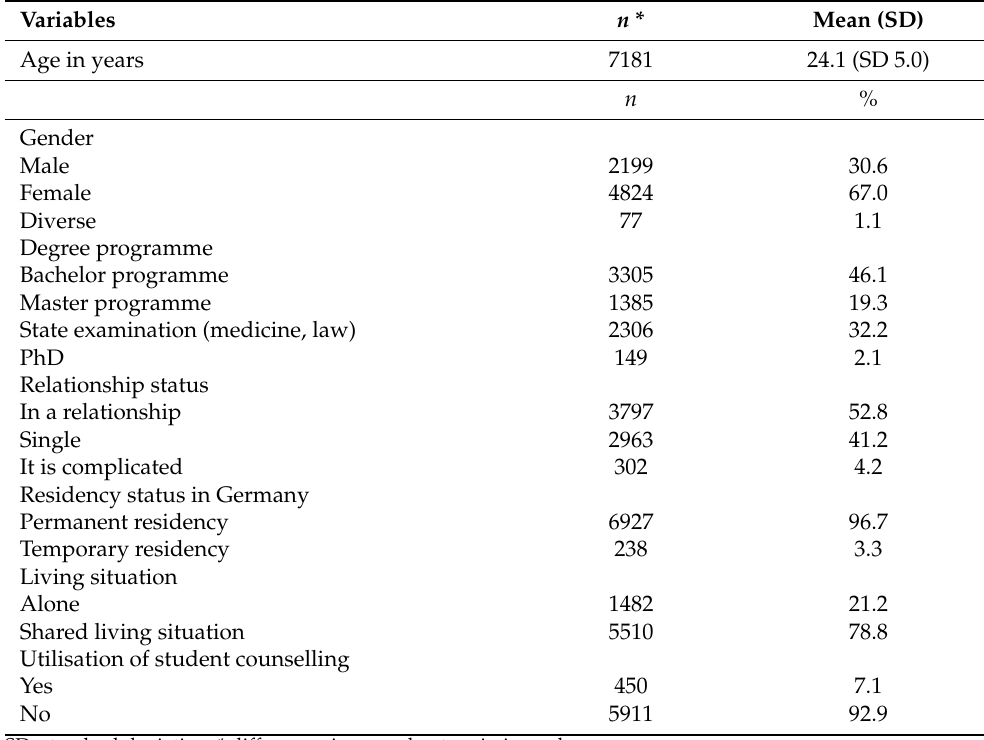
Table 1. Participant characteristics ( n =